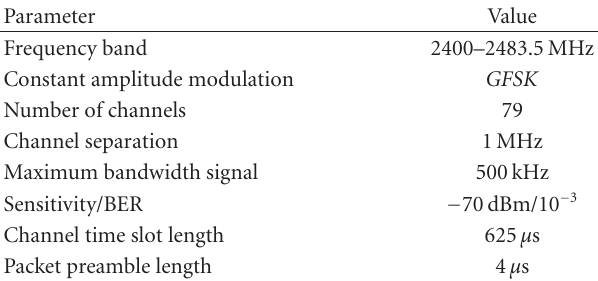
Table 1: Some specifications for Bluetooth